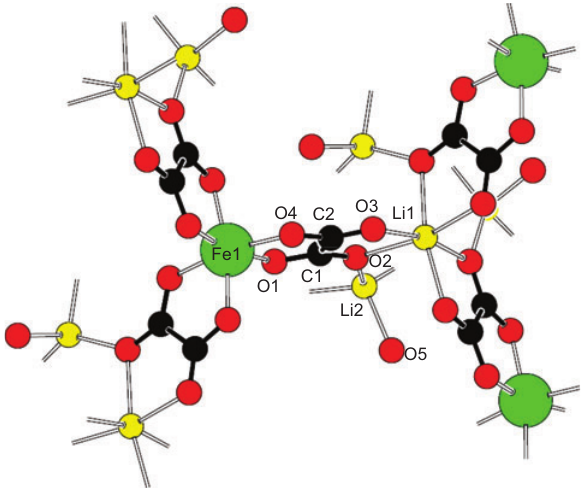
Figure 1 View of the atoms belonging to one sheet of [Fe(ox (H O) ]Cl · 6H O ( Declerq et al., 1993 Li 4 2 3 2